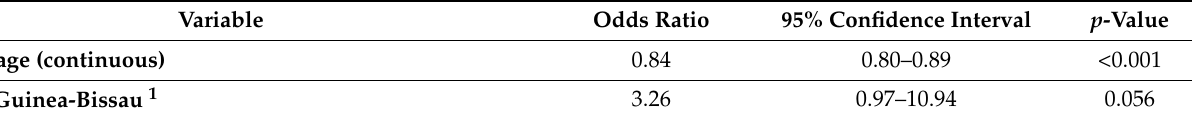
Table 2. Bivariate logistic regression analyses of correlates of underage initiation of selling sex among female sex worker study participants (n = 505) in Guinea-Bissau,